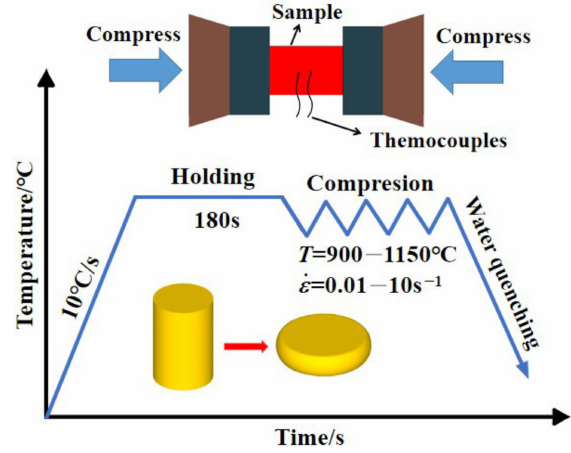
Figure 1. The scheme for the hot compression.